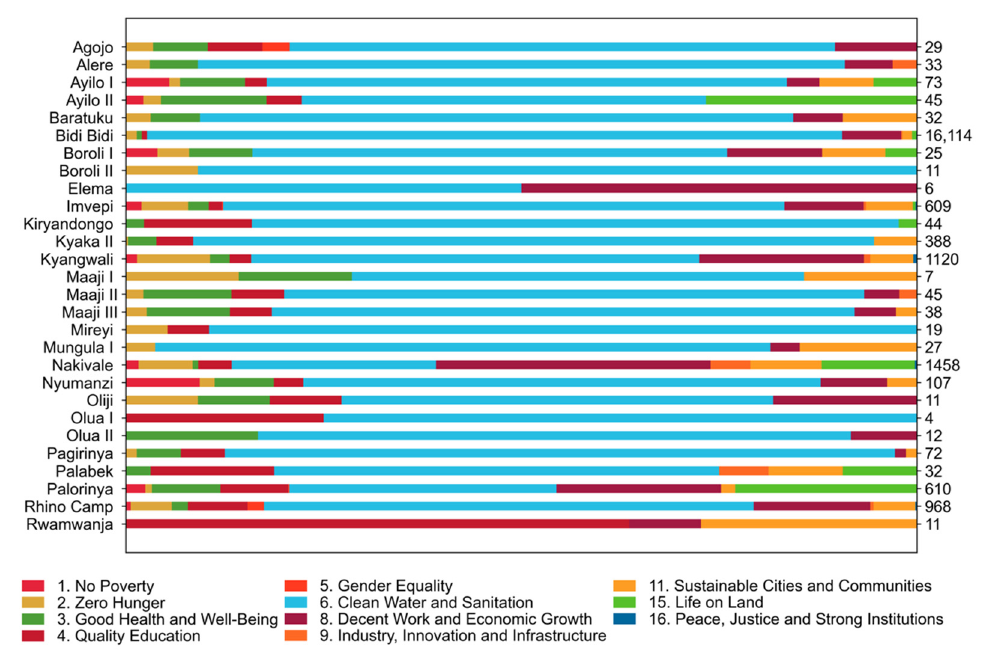
Figure 7. Relative distributions of SDG-relevant OSM data at refugee settlements. The total number of SDG-relevant OSM features within each settlement are listed on the right-hand side.